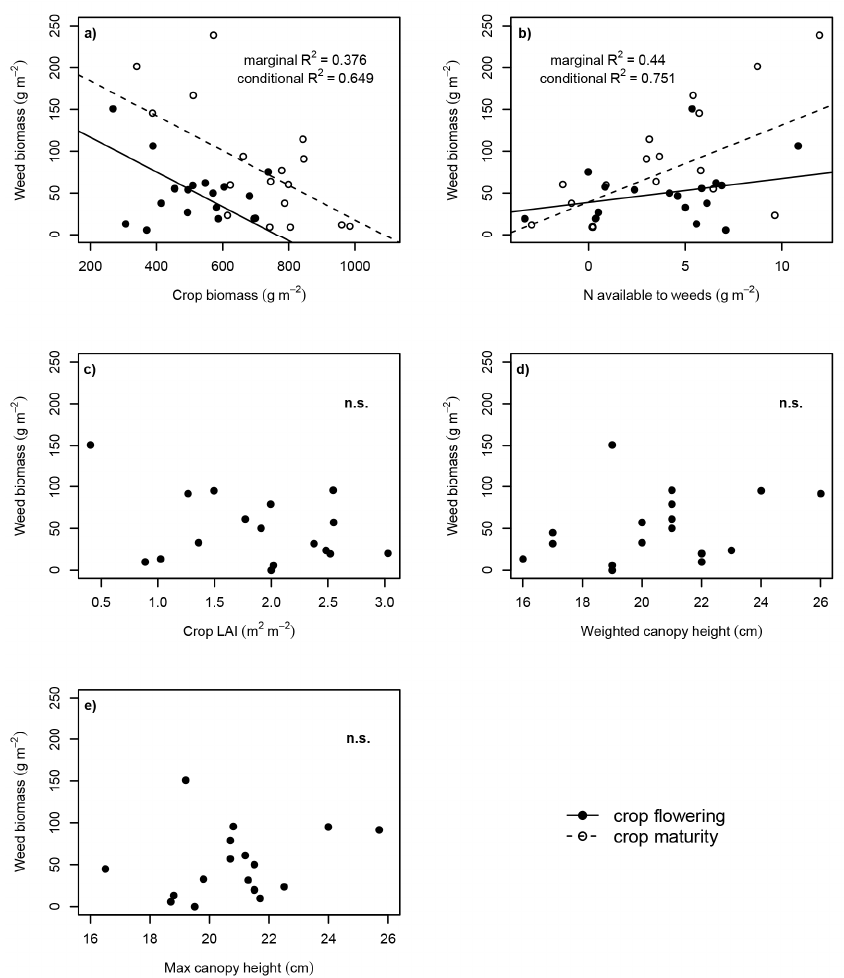
Figure 2. Relationships between weed biomass accumulation and characteristics of cropping arrangements at crop flowering and maturity. ( a ) Crop biomass ( p = 0.004; sampling time p = 0.006; Crop biomass × sampling time p = 0.104) and ( b ) N available to weeds ( p = 0.009; sampling time p = 0.969; N available to weeds × sampling time p = 0.003), both measured in the 15 N micro-plots, ( c ) crop LAI ( p = 0.185), ( d ) weighted canopy height ( p = 0.317) and ( e ) maximum canopy height ( p = 0.387), all measured in the large harvest plots. Marginal R 2 is the variance explained by the fixed effects; conditional R 2 is the variance explained by both fixed and random effects [28].